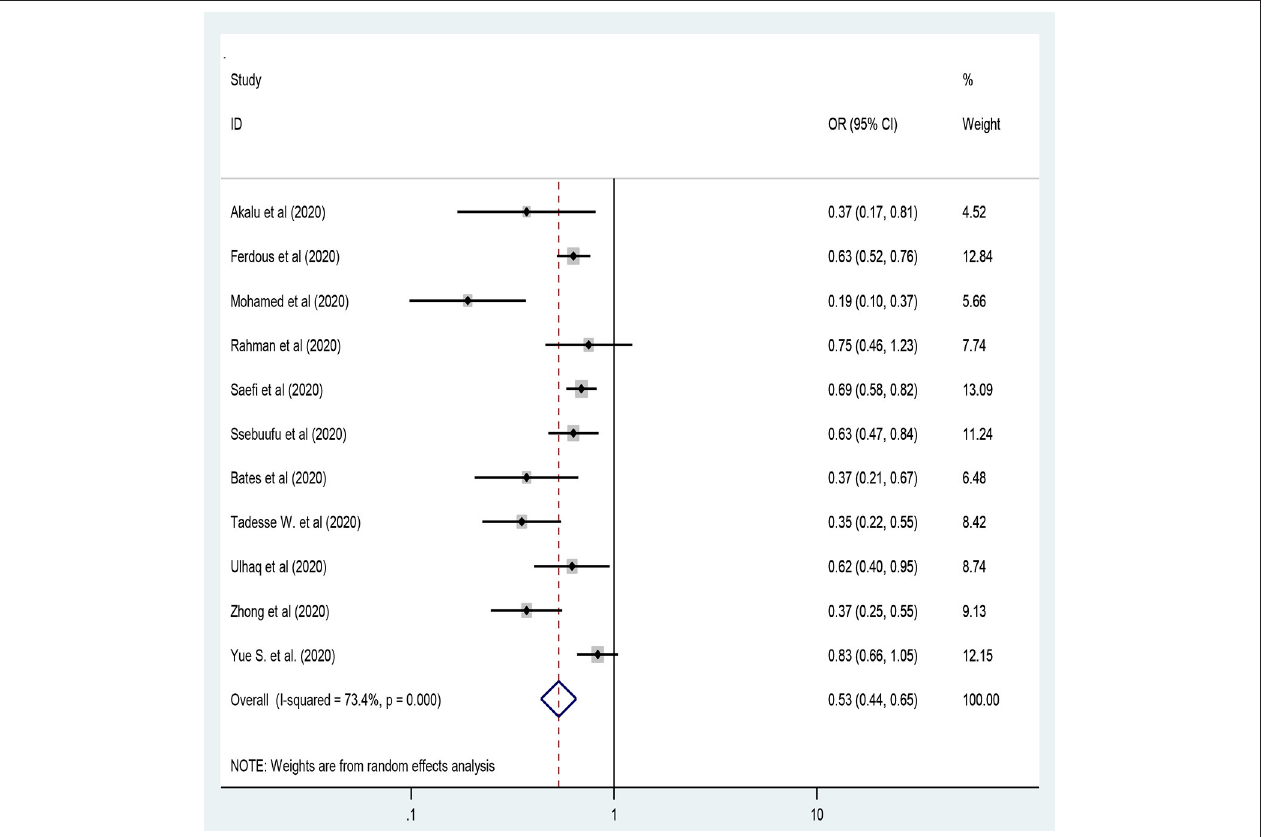
FIGURE 6 | The residence of the participants and preventive practice toward